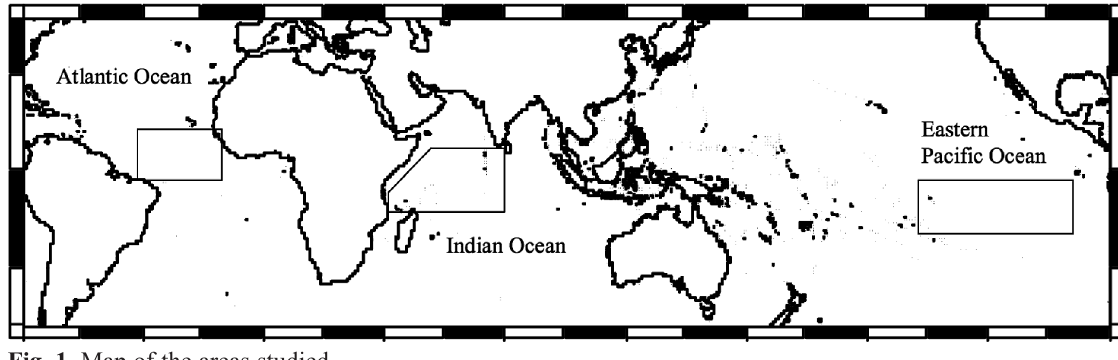
Fig. 1. Map of the areas